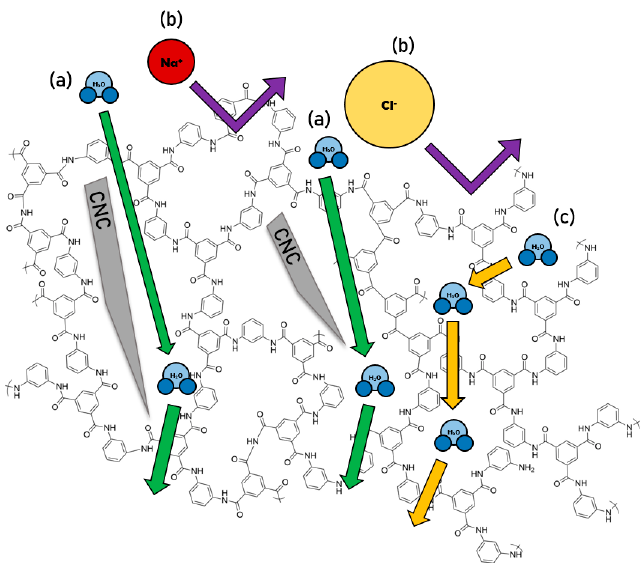
Figure 2. Illustration depicting known and proposed transport mechanisms within a thin-film nanocomposite membrane. ( a ) Improved transport of water molecules via interfacial nanochannel formation due to cellulose nanocrystal (CNC)-polyamide interactions; ( b ) Na + and Cl − ions rejected by polymer matrix; ( c ) conventional water transport through polyamide matrix; diffusion through network voids. Note: depictions of ions and nanoparticles are not to